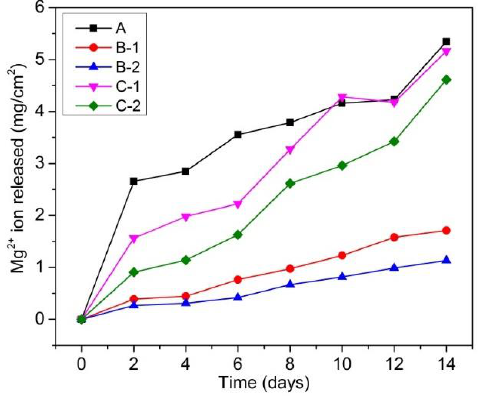
Figure 3. Mg 2+ ion release in the Hanks’ solution during immersion test.